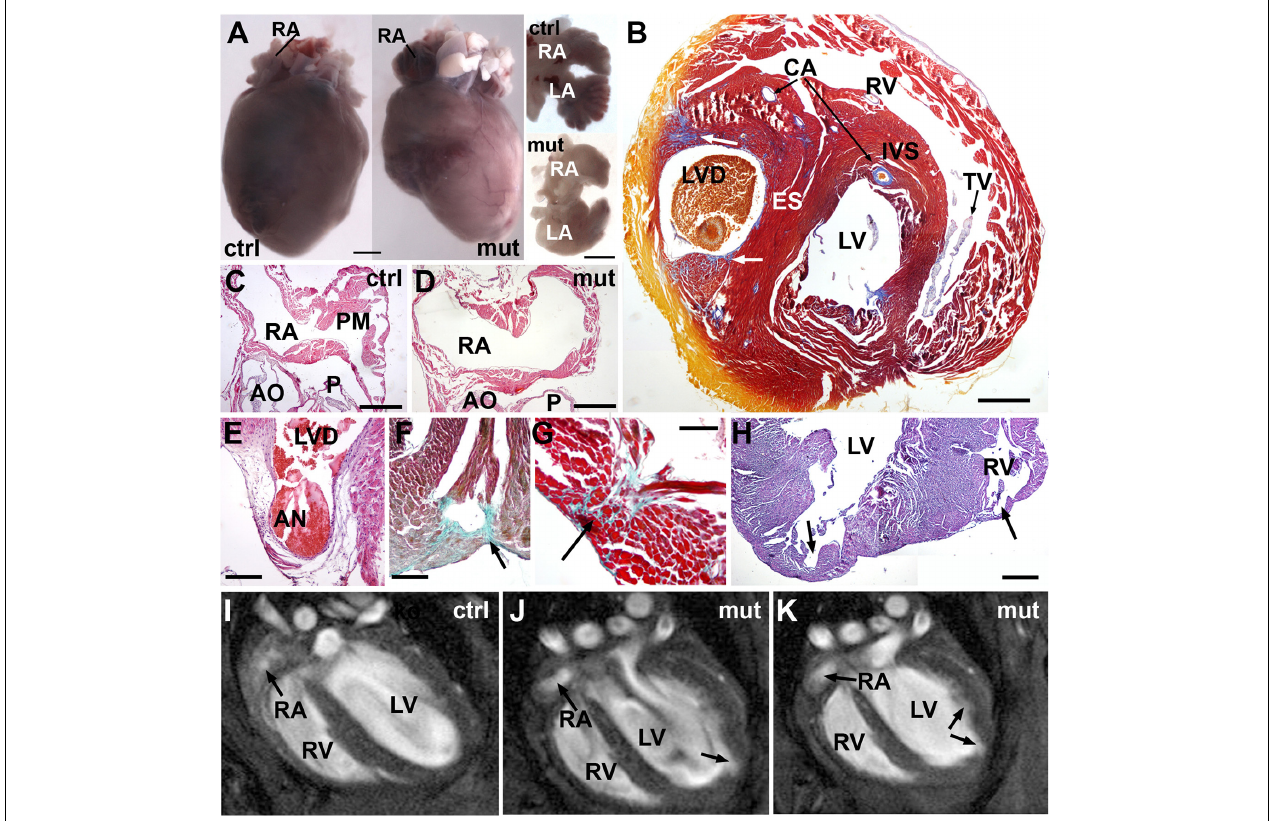
FIGURE 6 | Adult phenotype of the conditional WT1 loss of function in cardiomyocytes (Tnnt2 Cre / + ; WT1 flox / flox line). Representative images obtained from the analysis of 9 mutant mice. (A) Representative example of a mutant heart compared with a control. The mutant heart is smaller and shows irregular profiles. The dissected atria (ventral view) show different shapes due to lack of pectinate muscles. (B) Mallory’s trichrome stain. This heart of an adult mutant mouse shows an ectopic septum (ES) partially dividing the left ventricle in two chambers, the left one forming a blind diverticulum (LVD). Note some areas of fibrosis (arrows). Coronary arteries (CA) are well developed. IVS: interventricular septum; TV: tricuspid valve. (C,D) Right atrium (RA) of a control and a mutant adult heart, H&E stain. Note the lack of pectinate muscles (PM) in the mutant atrium. AO, aortic root; P, pulmonary root. (E) The left ventricle diverticulum shown in (B) ends in a fibrous aneurism (AN) located in the base of the left ventricle. H&E stain. (F–H) Defects in the free ventricular walls consisting of disorganized and fibrotic areas (arrows in F,G , Masson-Goldner’s stain) and diverticula (arrows in H , H&E stain). (I–K) MRI images of the heart in a control (I) and a mutant mouse (J,K) . The inner surface of the